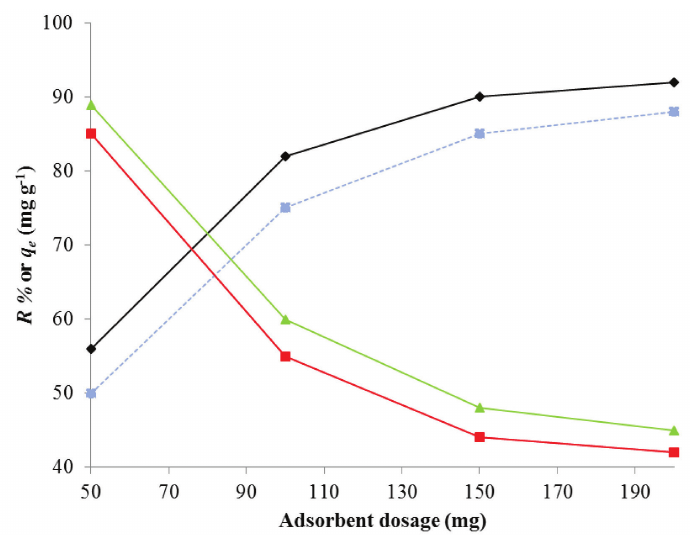
Fig. 8 – Effect of adsorbent dosage on the removal % and adsorption capacity (γ